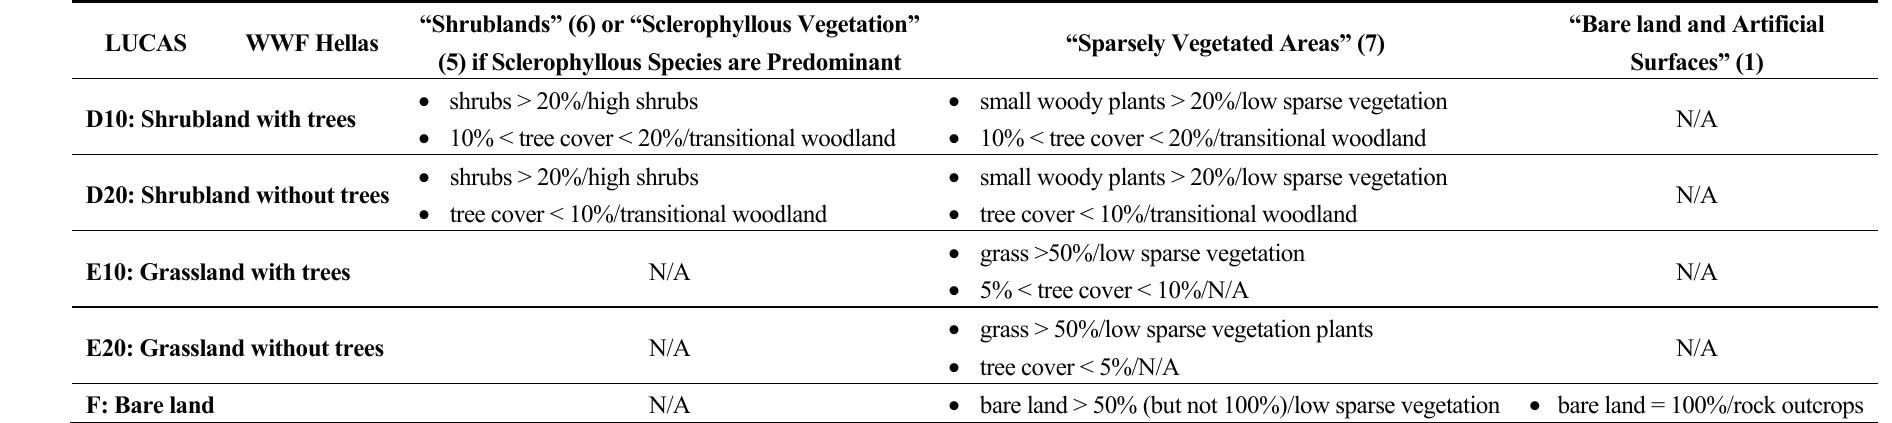
Table 3. A summary of shrubland and grassland categories for LUCAS and WWF Hellas classification systems and respective criteria (criteria in bullets; LUCAS criteria before slash and WWF Hellas criteria after slash,